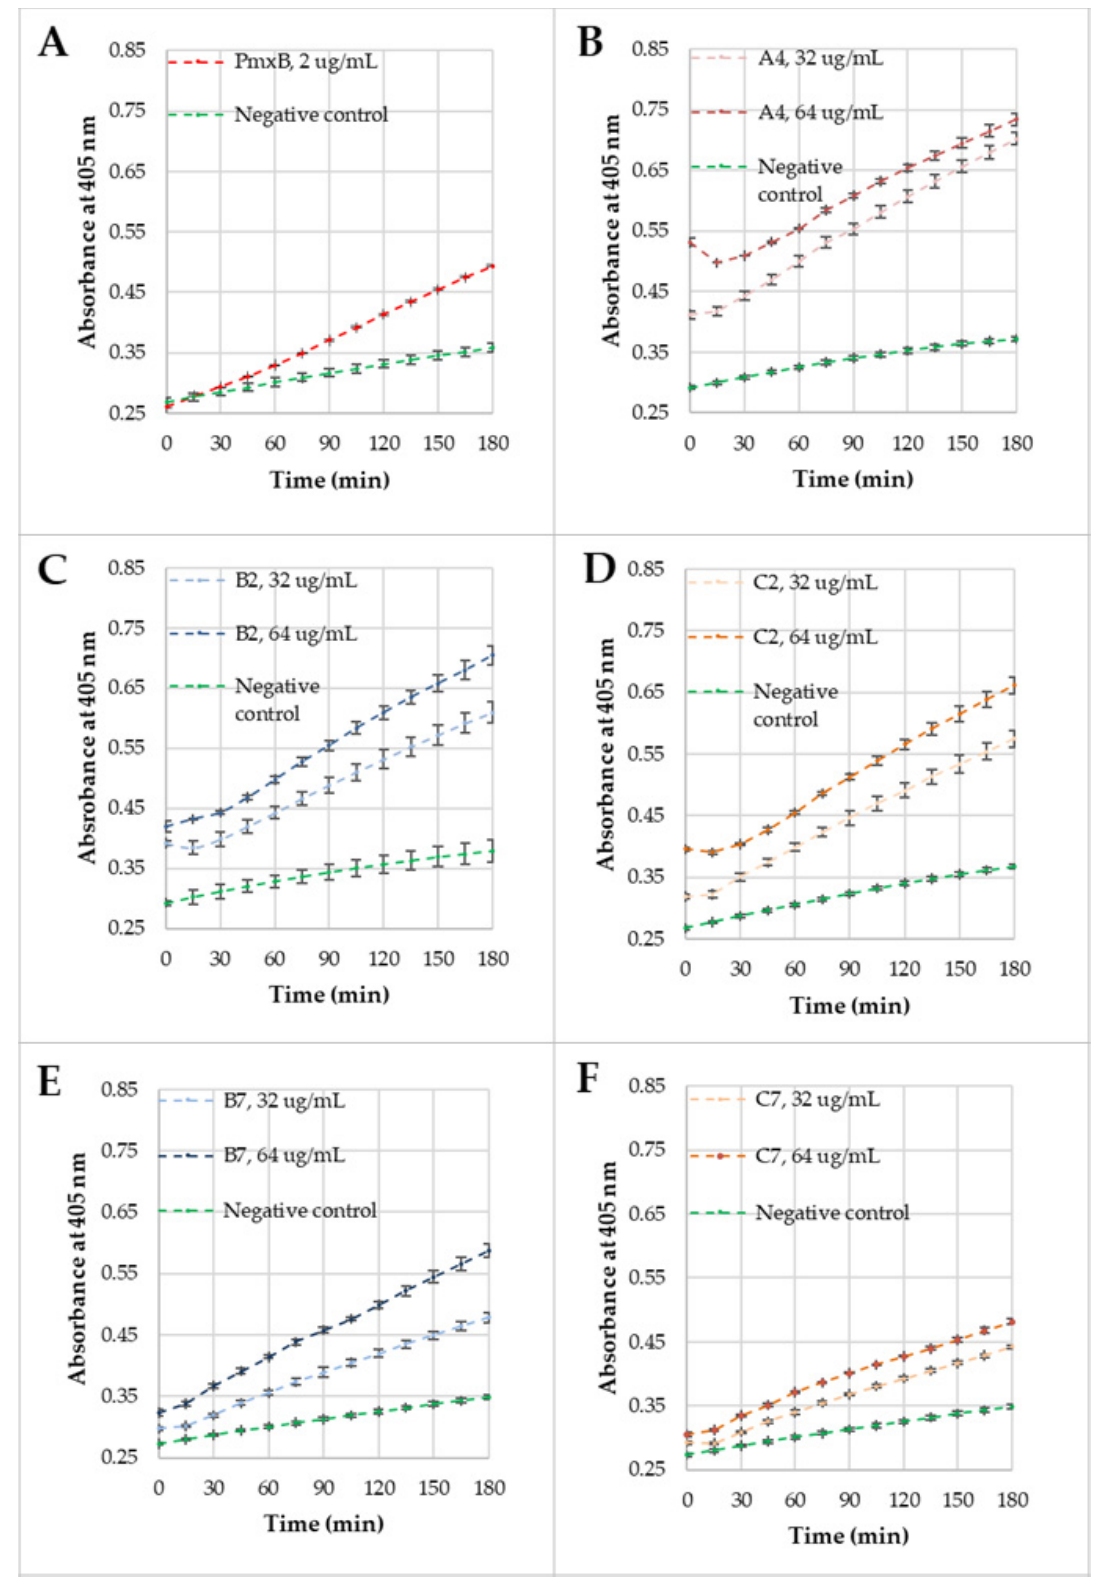
Figure 10. Outer membrane (OM) permeabilization kinetics. ( A ) Polymyxin B at 2 µg/mL; ( B ) A4 at 32 and 64 µg/mL; ( C ) B2 at 32 and 64 µg/mL; ( D ) C2 at 32 and 64 µg/mL; ( E ) B7 at 32 and 64 µg/mL; ( F ) C7 at 32 and 64 µg/mL.